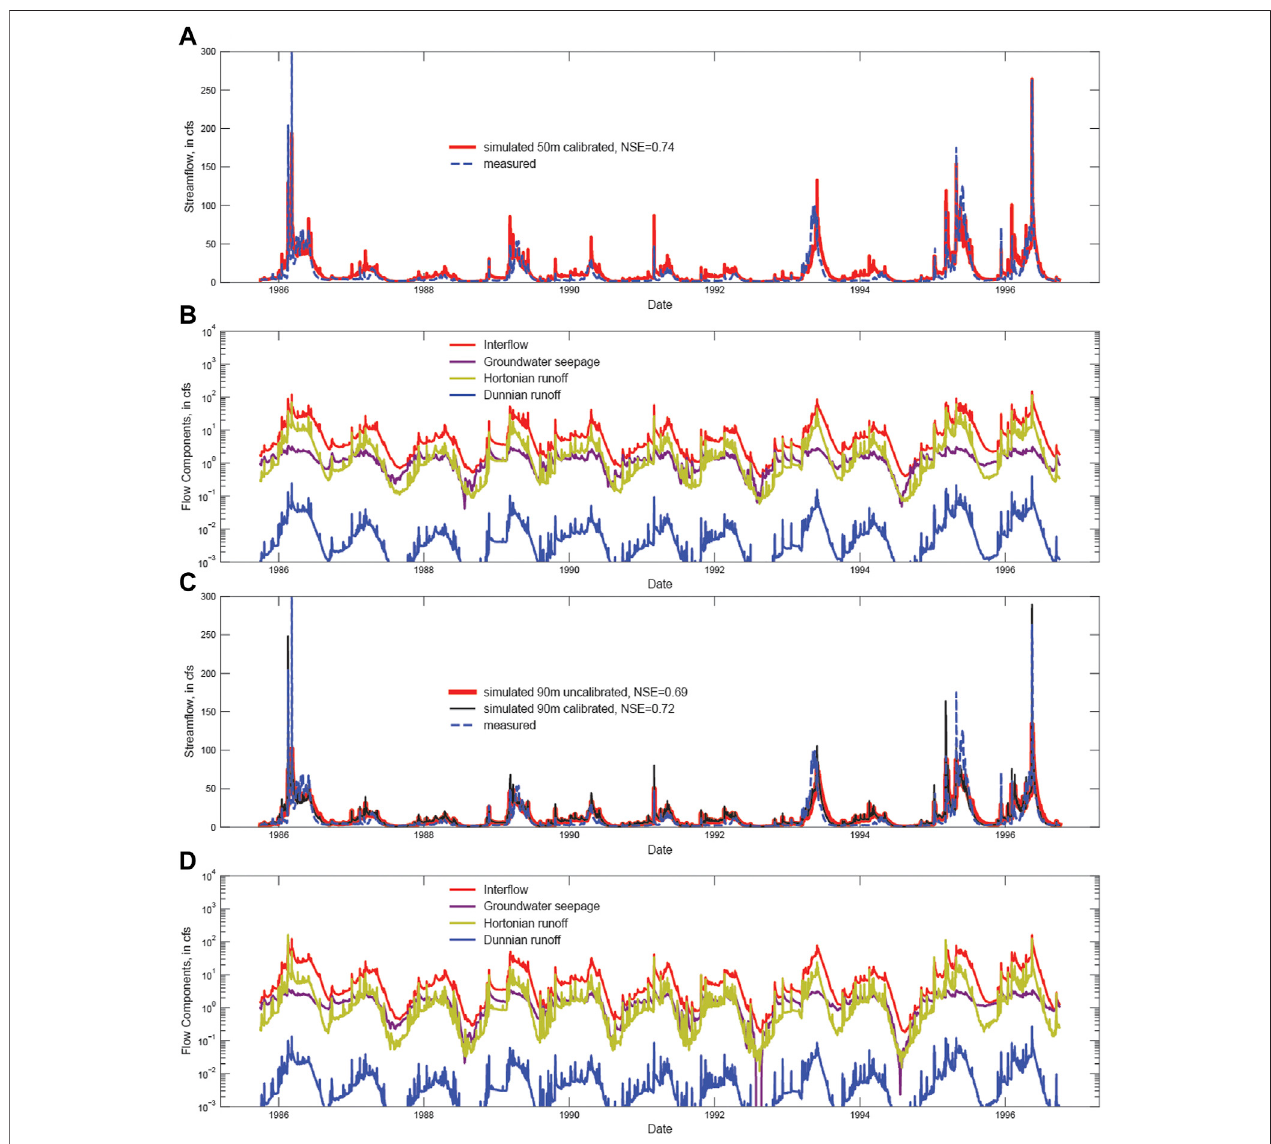
FIGURE7| SagehenCreektestmodel(Larsenetal.,2021)resultsshowingcomparisonsbetweensimulatedandmeasured stream fl ow(10,343,500SAGEHENC NRTRUCKEECA;U.S.GeologicalSurvey, 2021)and contributionstostream fl owfor (A,B) 50 m×50 m,and (C,D) 90 m×90 mmodelcellsizes,respectively.All fl ows correspond to the location of the streamgage at the outlet of the watershed shown in Figure 6 . Part (C) shows simulated versus measured fl ows for parameters unchanged from the 50 m calibration used in the 90 m calibration and the calibrated 90 m simulation.